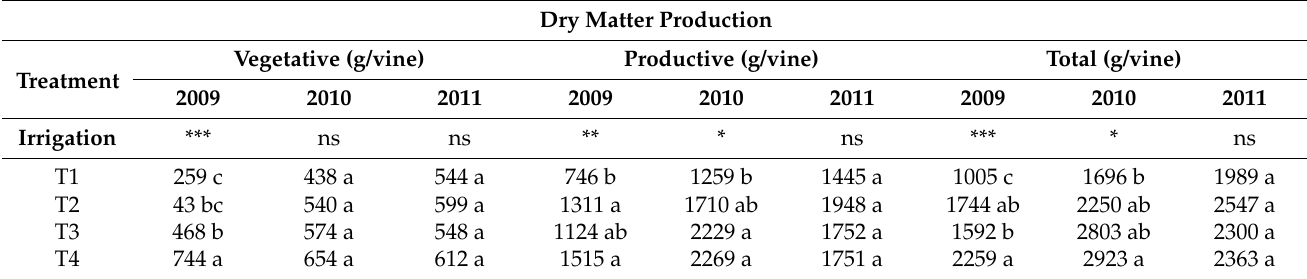
Table 7. Total dry matter production, vegetative (clipping + pruning) and productive (harvest), for the different high load irrigation treatments, in the years 2009, 2010, and 2011.